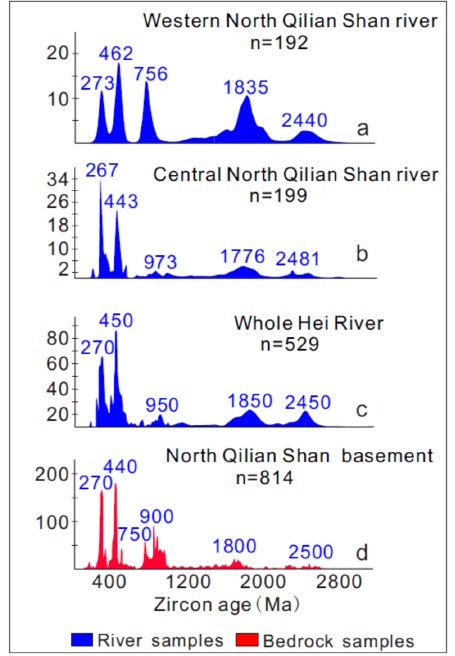
Figure 5. Comparison of the U-Pb age peaks of detrital river zircon grains from Western North Qilian Shan (( a ), [92]), Central North Qilian Shan (( b ), [93]), whole Hei River (( c ), [90]) with those from the North Qilian Shan (( d ),